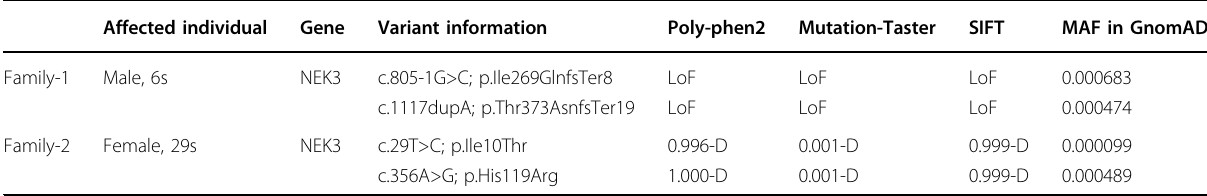
Table 1 Biallelic NEK3 mutations in two unrelated individuals with defective LR patterning. Affected individual Gene Variant information